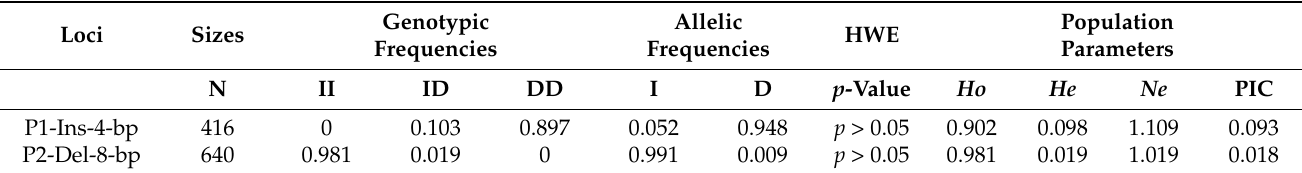
Table 2. Genetic parameters of InDels within the HOXA11 gene in SDBCGR population.